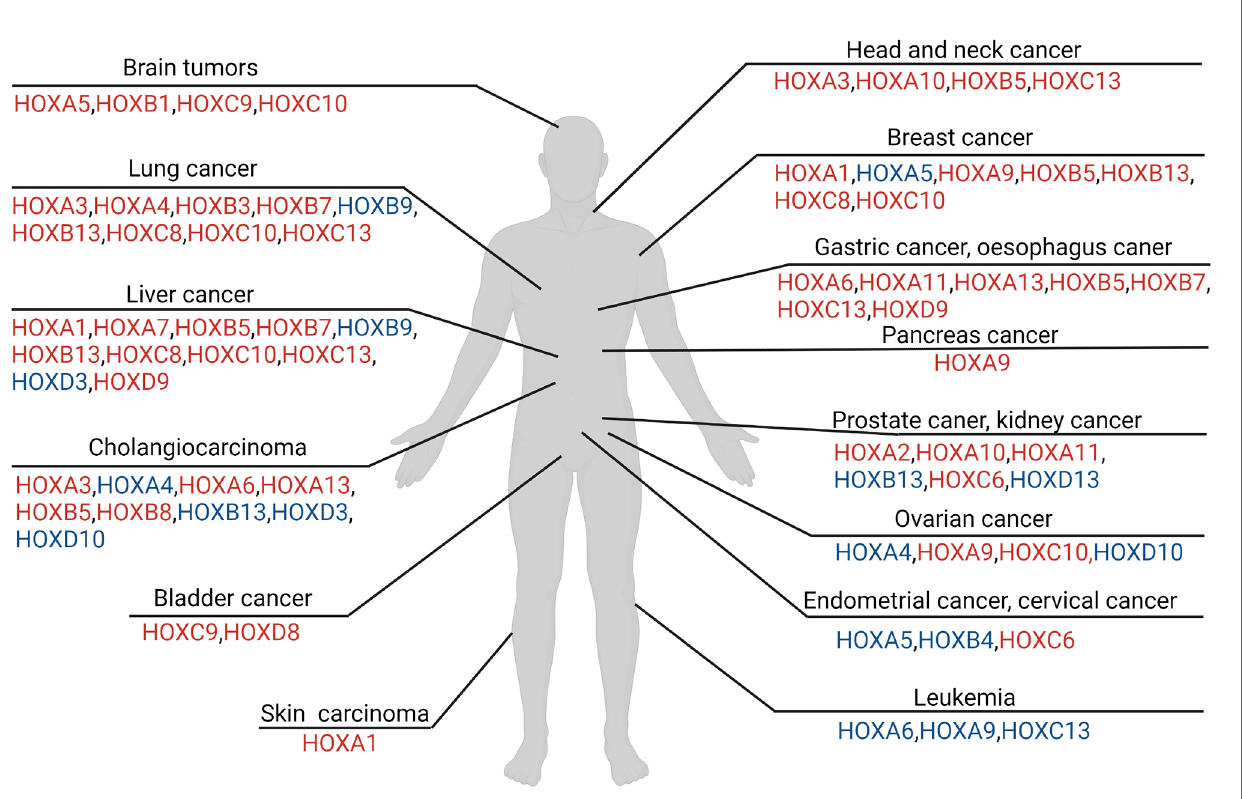
FIGURE 1 | Overview of HOX involvement in different tumors in human. The colors of HOX molecules indicate regulations in relevant tumor cell. The red font means the corresponding HOX genes is up-regulated in tumor, while the blue font means the corresponding HOX genes is down-regulated in comparison. Regulation of HOX factors in various tumor types described in this fi gure legend. [brain cancer mainly includes the glioma and neuroblastoma (4 – 11), lung cancer (12 – 24), hepatocellular carcinoma (25 – 31), bladder cancer (32, 33), cholangiocarcinoma (34), head and neck squamous cell carcinoma (35, 36), breast cancer (21 – 23, 37 – 54), gastric carcinoma and esophagus cancer (55 – 64), prostate cancer and renal carcinoma (43, 65 – 72), ovarian cancer (73 – 79), endometrial cancer and cervical cancer (80 – 84), leukemia (85 – 95), skin carcinoma (96 –